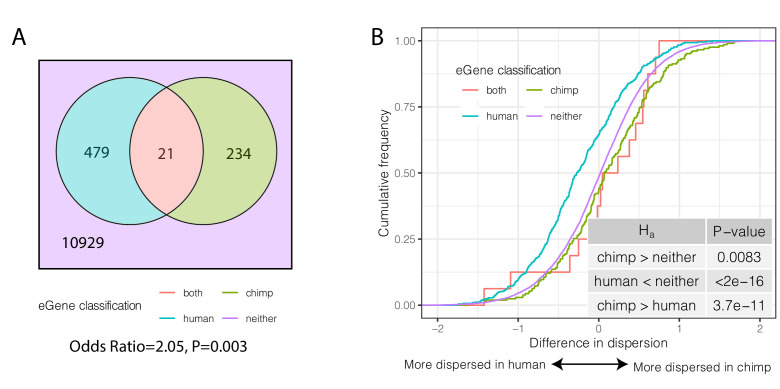
Species-sharing and dispersion of eGenes.(A) eGenes were classified by a 10% FDR threshold in chimpanzee and considering only the top 500 eGenes by FDR in human (GTEx). (B) ECDF of the difference in dispersion of genes between chimpanzee and human. Chimpanzee-specific eGenes are more dispersed in chimpanzee; human-specific eGenes are more dispersed in human. p-Values provided for one-sided Mann-Whitney U-test with the noted alternative hypothesis.